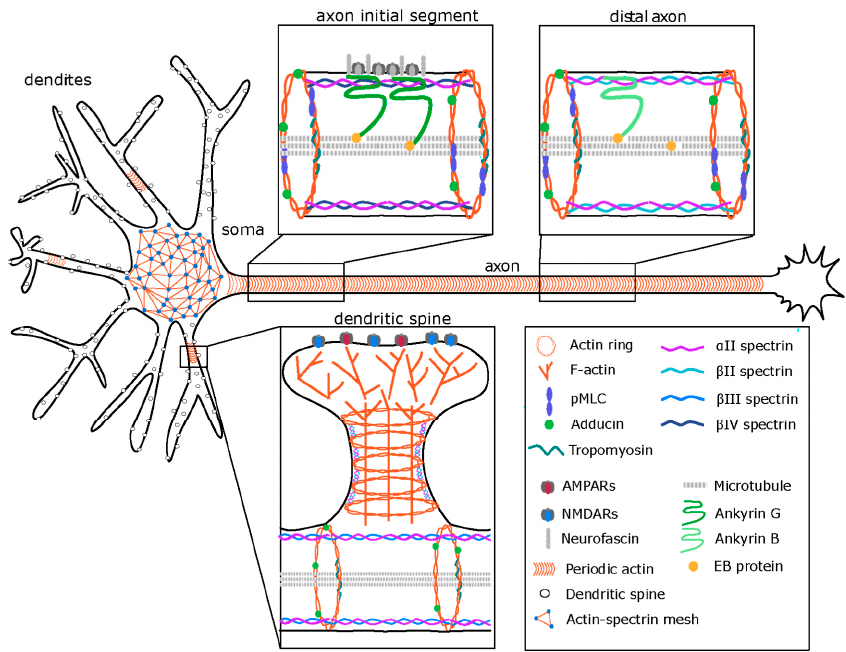
Figure 1. The organization of the neuronal cytoskeleton. A two-dimensional (2D) actin-spectrin meshwork, similar to those found in other cell types (e.g., erythrocytes), spans the soma of the cell. In contrast, a one-dimensional (1D) periodic membrane cytoskeleton (MPS) is found in axons, in a fraction of dendrites and at the neck of dendritic spines. Top: The MPS consists of actin rings at a periodicity of ~200 nm, interspersed with spectrin tetramers. Each actin ring is formed by two braided actin filaments. The actin rings are further stabilized and regulated by the capping protein adducin and by tropomyosin. The spectrin tetramers are comprised of two α II spectrins and two compartment specific isoforms of β -spectrin. The axon initial segment (AIS) is a stretch of 50–100 µm at the beginning of the axon. The major scaffold in the AIS is AnkyrinG (AnkG), which binds to spectrin β IV and recruits the adhesion molecule neurofascin and ion channels. Phosphorylated myosin light chain (pMLC) is localized to actin rings in the axon. Microtubule bundles are stabilized by plus end binding proteins (EB) along the axon in both the AIS and the distal axon. In the distal axon the MPS is organized by AnkB, which in turn binds to β II-spectrin. AnkB is also arranged periodically, though the pattern is less prominent. Bottom: Dendritic spines are important for compartmentalization of synaptic signaling conferred by glutamate receptors and calcium channels. While the head of the spine contains branched actin filaments, the MPS is prominent in the neck region. Likely consisting of acting rings interspersed by α II and β II-spectrin tetramers. The MPS has also been observed in a sub-fraction of mature dendrites. Here, spectrin tetramers contain the β III-spectrin isoform.